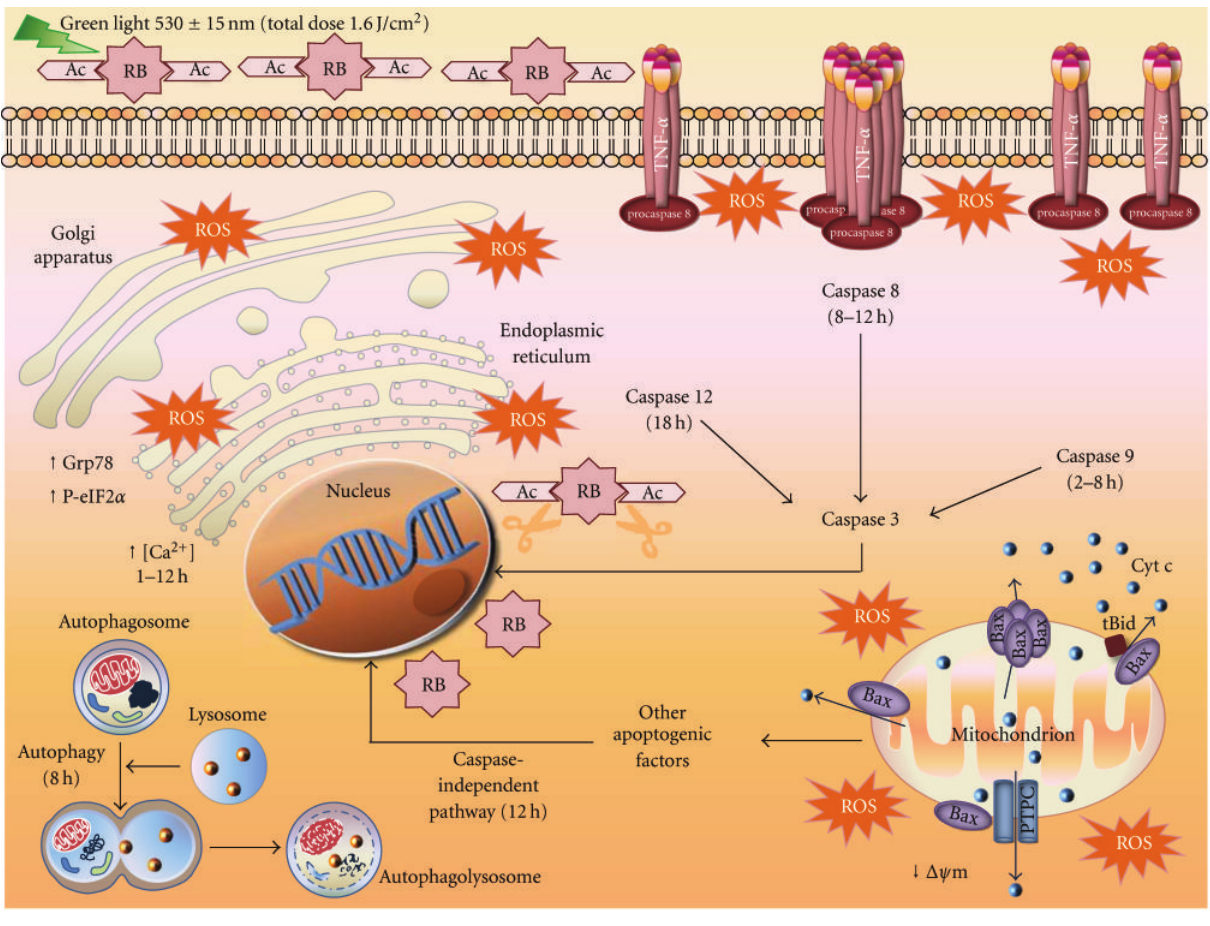
Figure 3: RBAc-PDT-mediated photocytotoxicity in HeLa tumour cells. RBAc (Rose Bengal Acetate) crosses the plasma membrane localizing in perinuclear region. Cytoplasmic esterases remove acetate groups and restore photoactive Rose Bengal molecules, producing ROS when excited by visible green light at 530 ± 15nm (Total dose 1.6 J/cm 2 ). RBAc treatment induces cell death in HeLa cells by apoptosis